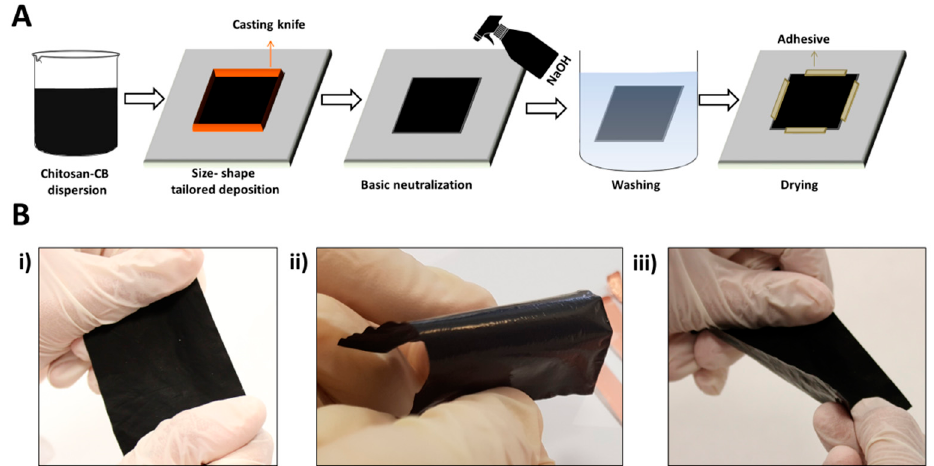
Figure 1. Flexible CH-CB membrane, 100% w/w of CB. ( A ) Fabrication strategy and ( B ) visual examination of the resilience to mechanical strain: (i) stretching, (ii) bending, and (iii) twisting.